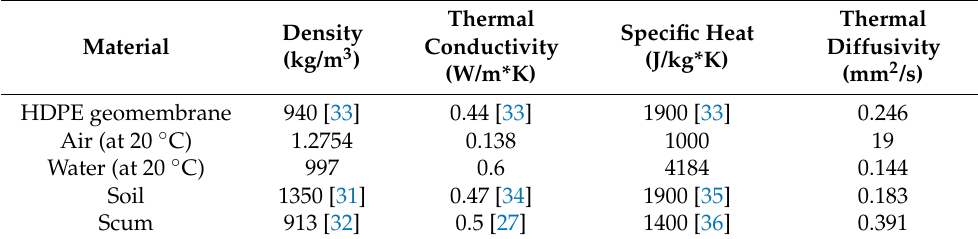
Table 4. Summary of material properties in the experiment.